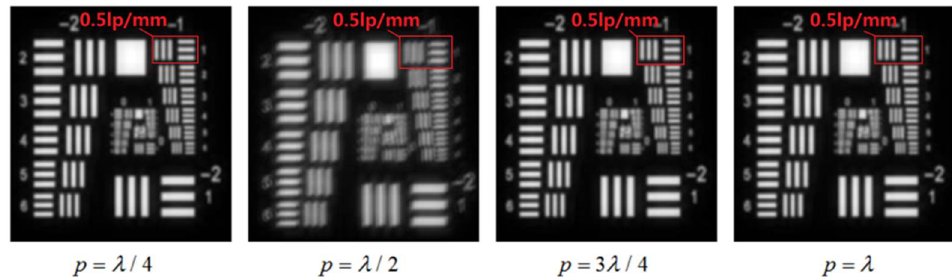
Figure 6. Simulated imaging without cophasing error.